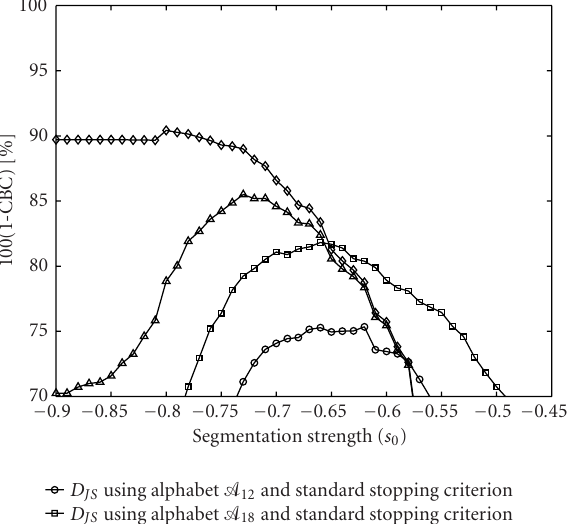
Figure 14: Accuracies of recursive segmentation for di ff erent thresholds of segmentation strength using Jensen-Shannon and Jensen-R´enyi divergences with (cid:1) 12 and (cid:1) 18 alphabets and two stop- ping criterions for the genome of bacterium Methanococcus jan- naschii